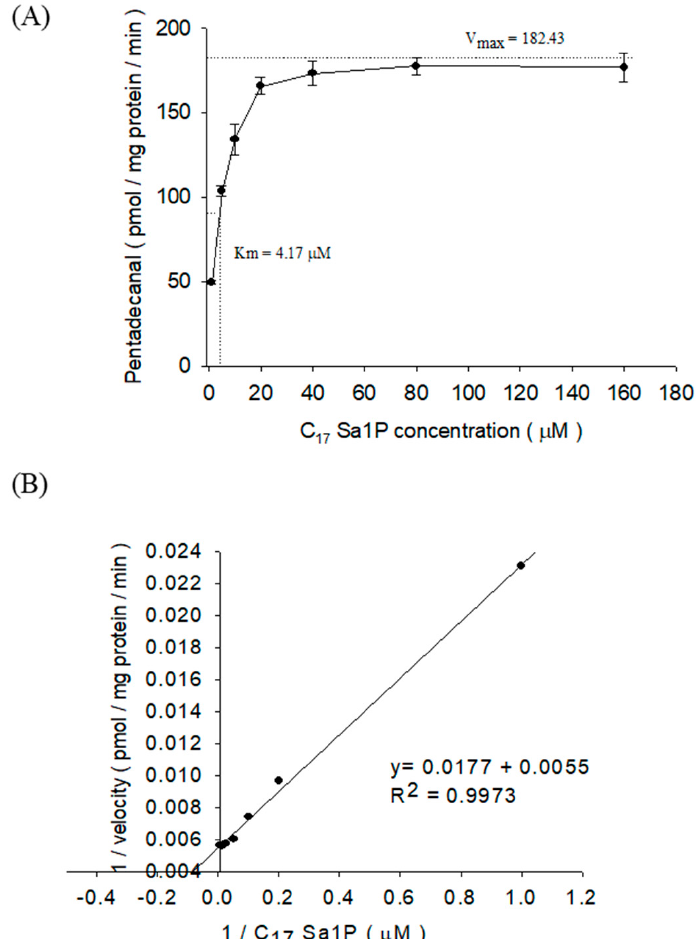
Figure 7. S1PL activity as a function of substrate concentration ( A ) and the S1PL reaction for 20 min with variable amounts of C17 Sa1P and 50 µg of cell lysate proteins ( B ). The data represent the mean ± SD of triplicate analyses.